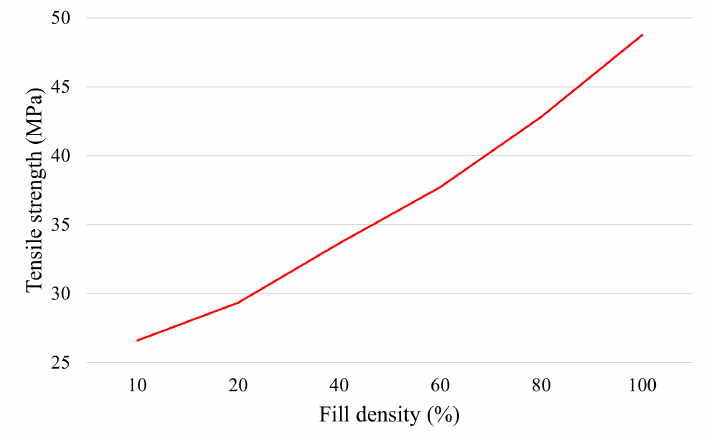
Figure A12. Graphs tensile strength vs. fill density generated from the